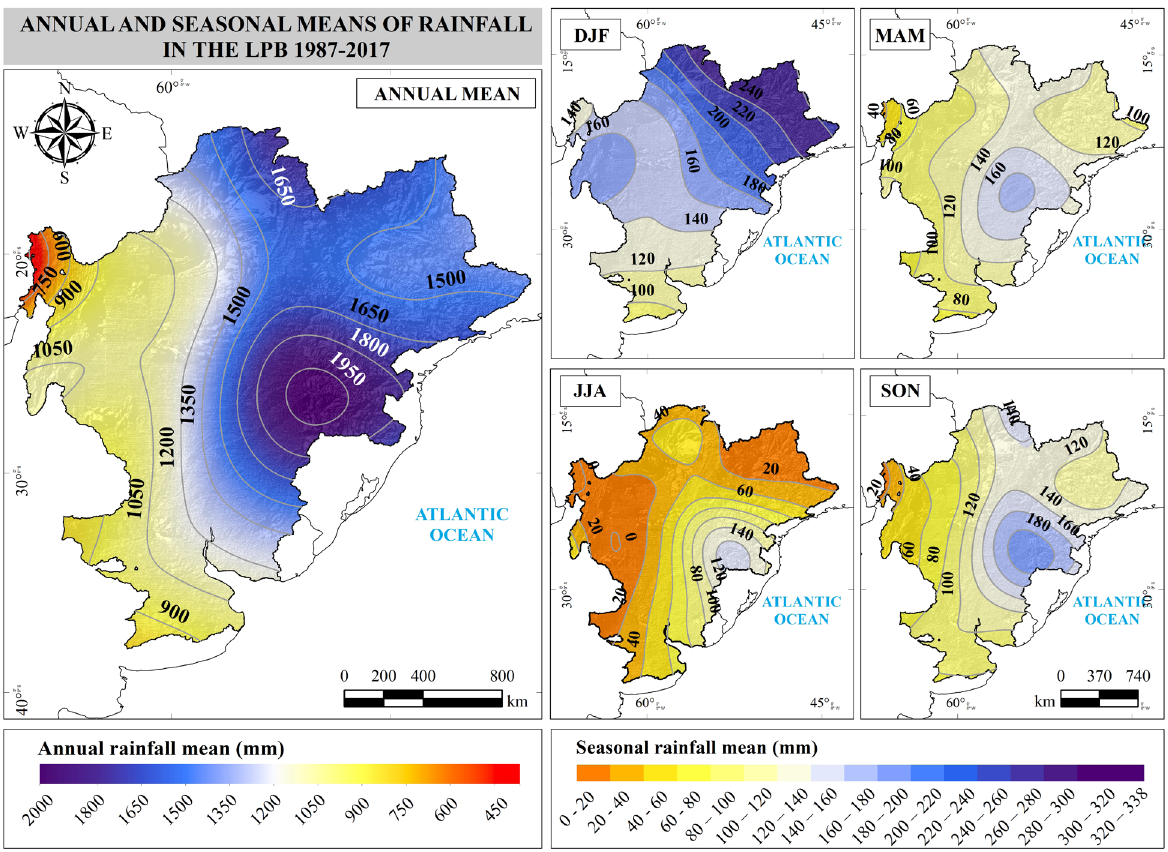
Figure 6. Annual and seasonal means rainfall in the La Plata Basin (LPB) for the period